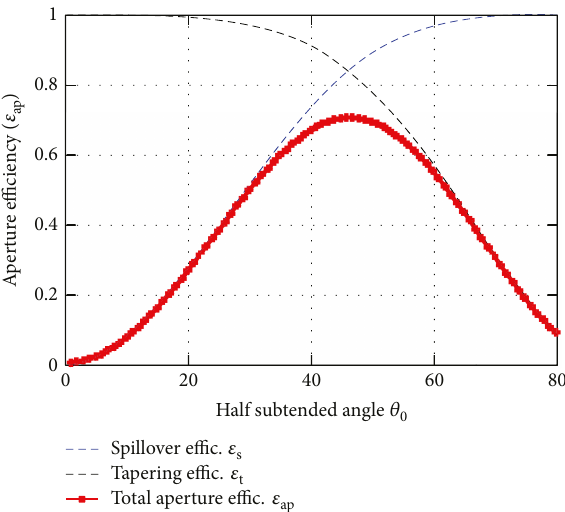
Figure 7: Simulated aperture e ffi ciency versus half subtended angle of the re fl ector.